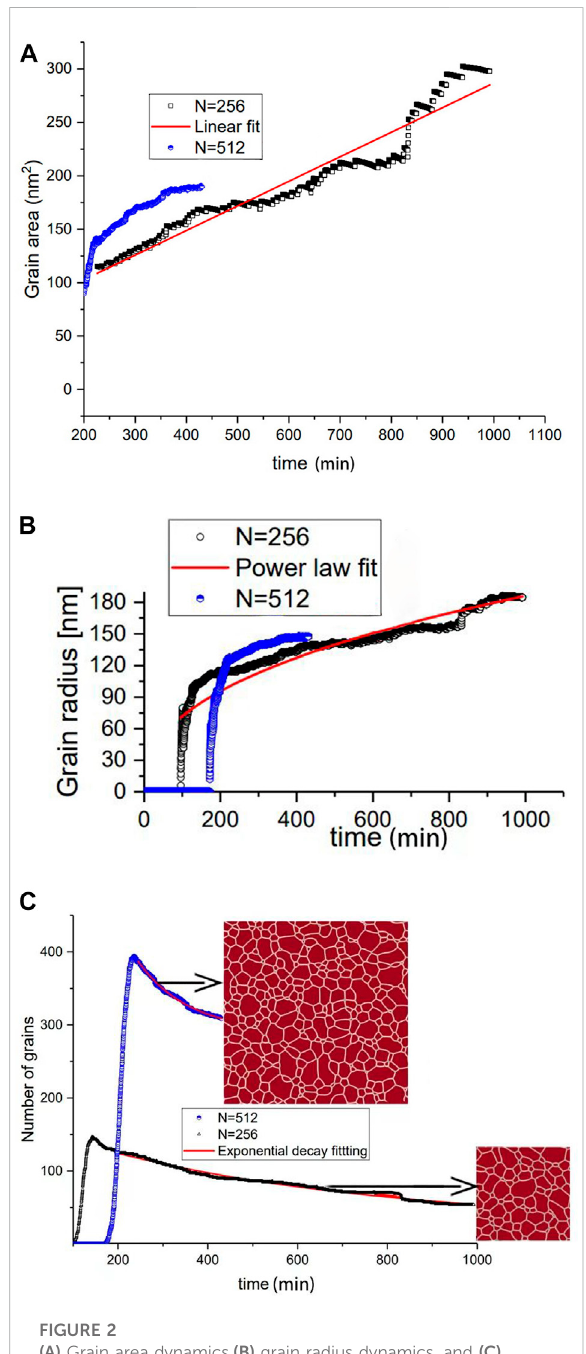
FIGURE 2 (A) Grain area dynamics, (B) grain radius dynamics, and